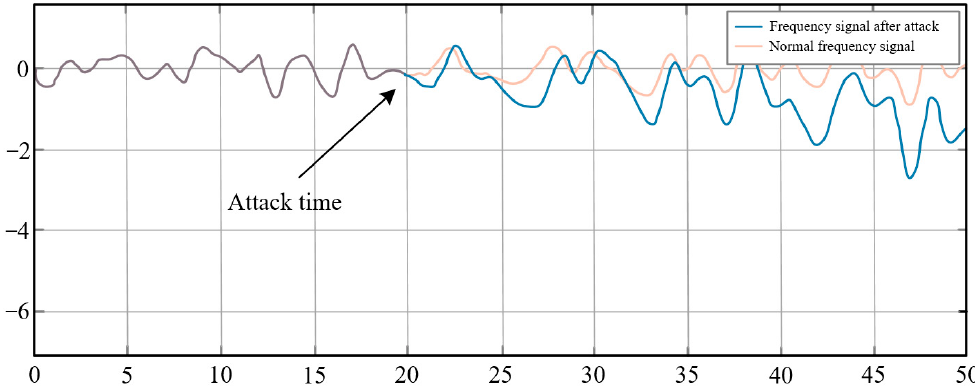
Figure 4. Change in system frequency deviation signal after being attacked by medium-strength negative compensation ACE signal in the 20ths.